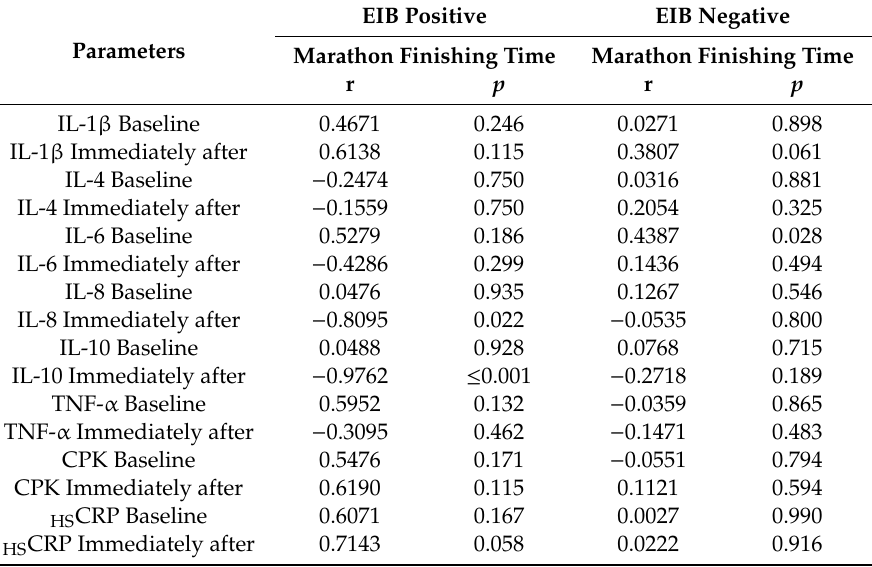
Table 4. Correlations between marathon finishing time and blood markers of all volunteers and by groups. International Marathon of Sao Paulo